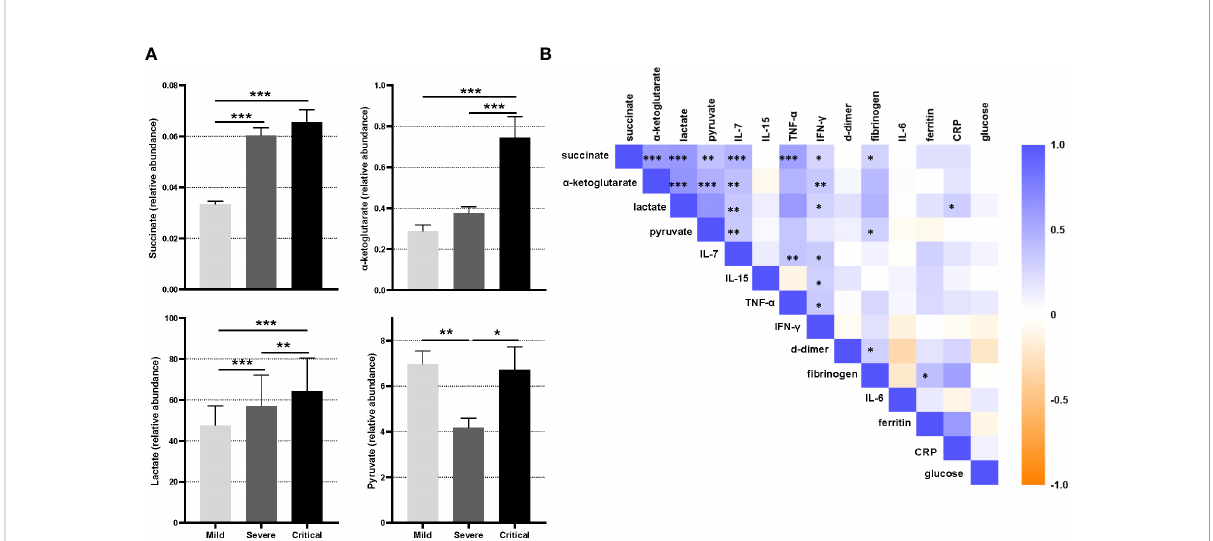
FIGURE 2 Semi-targeted metabolomics study of patients in cohort 1. (A) Relative abundance of succinate, a -ketoglutarate, lactate and pyruvate acid in patients grouped by disease severity (mild, severe and critical). Statistical signi fi cance between different groups was estimated using the Kruskal- Wallis test. Bars represent median values ± SEM. (B) Correlation matrix between relevant parameters previously related to COVID-19 severity and metabolites measured in patients of cohort 1. The color of the squares corresponds to the absolute value of the Spearman correlation coef fi cient, with orange or blue color indicating negative or positive correlation, respectively. A blank square indicates a lack of correlation between variables. The results were considered signi fi cant at *P<0.05; **P<0.01; ***P<0.001.